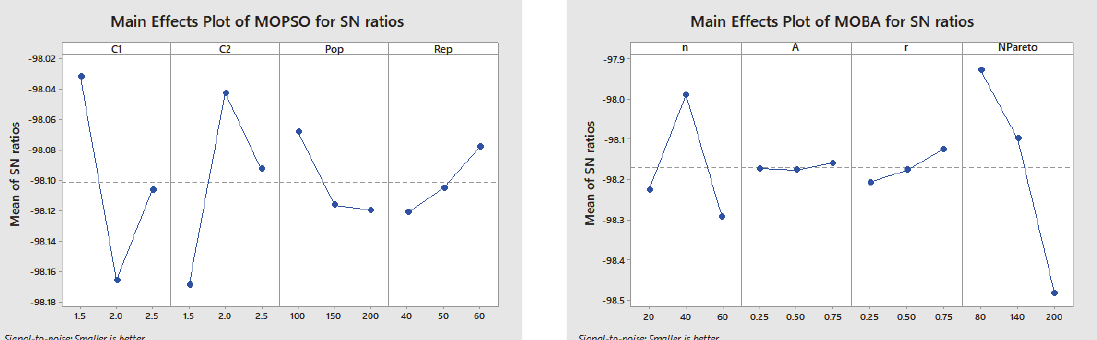
Fig. 6. Main effect plot of MOPSO and MOBA for S/N ratios (WIP inventory